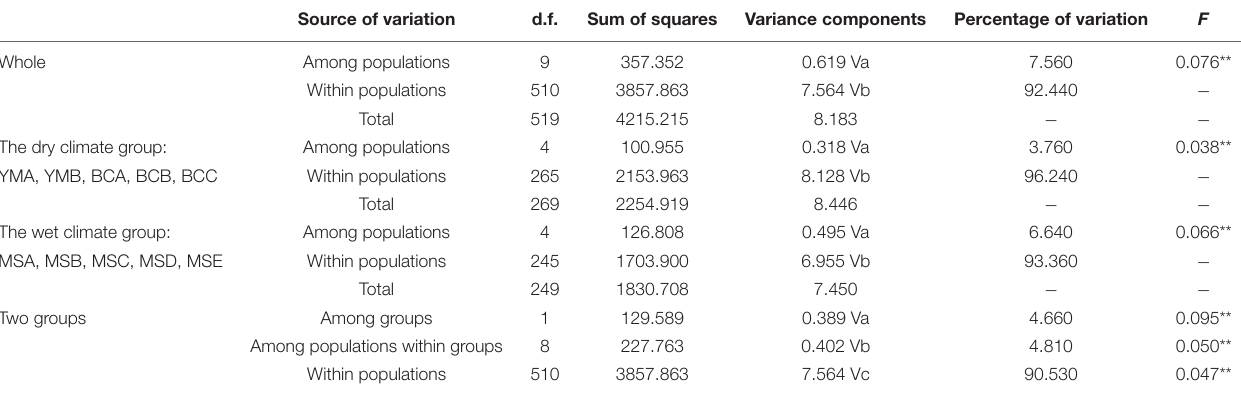
FIGURE 8 | Principal coordinate analysis (PCoA) of 260 P. emblica individuals from 10 populations, based on a genetic distance matrix of 20 EST-SSRs. The PCoA1 explains 6.54% of the total genetic variance, and the PCoA2 accounts for 2.91%. The confidence interval of 95% is showed as polygon. TABLE 4 | Analysis of molecular variance (AMOVA) based on 20 EST-SSR markers for populations of P. emblica . Source of variation d.f. Sum of squares Variance components Percentage of variation